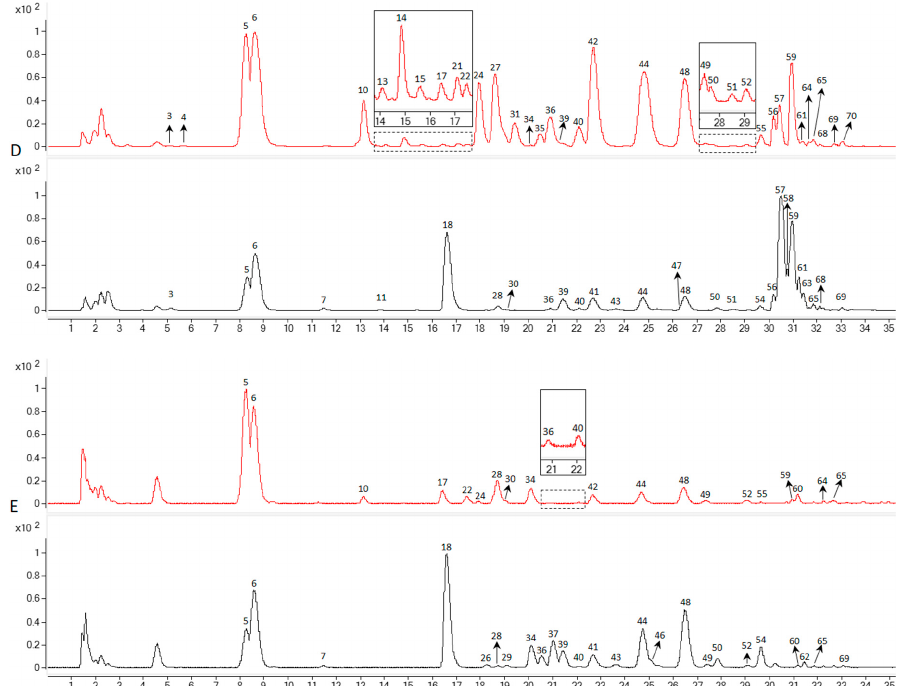
Figure 4. The base peak chromatogram (BPC) profiles of different parts of New Zealand ‐ grown Asian ginseng (NZPG, red line) and New Zealand ‐ grown American ginseng (NZPQ, black line). ( A ) Ginseng fine root, ( B ) ginseng rhizome, ( C ) ginseng main root, ( D ) ginseng leaf, ( E ) ginseng stem.